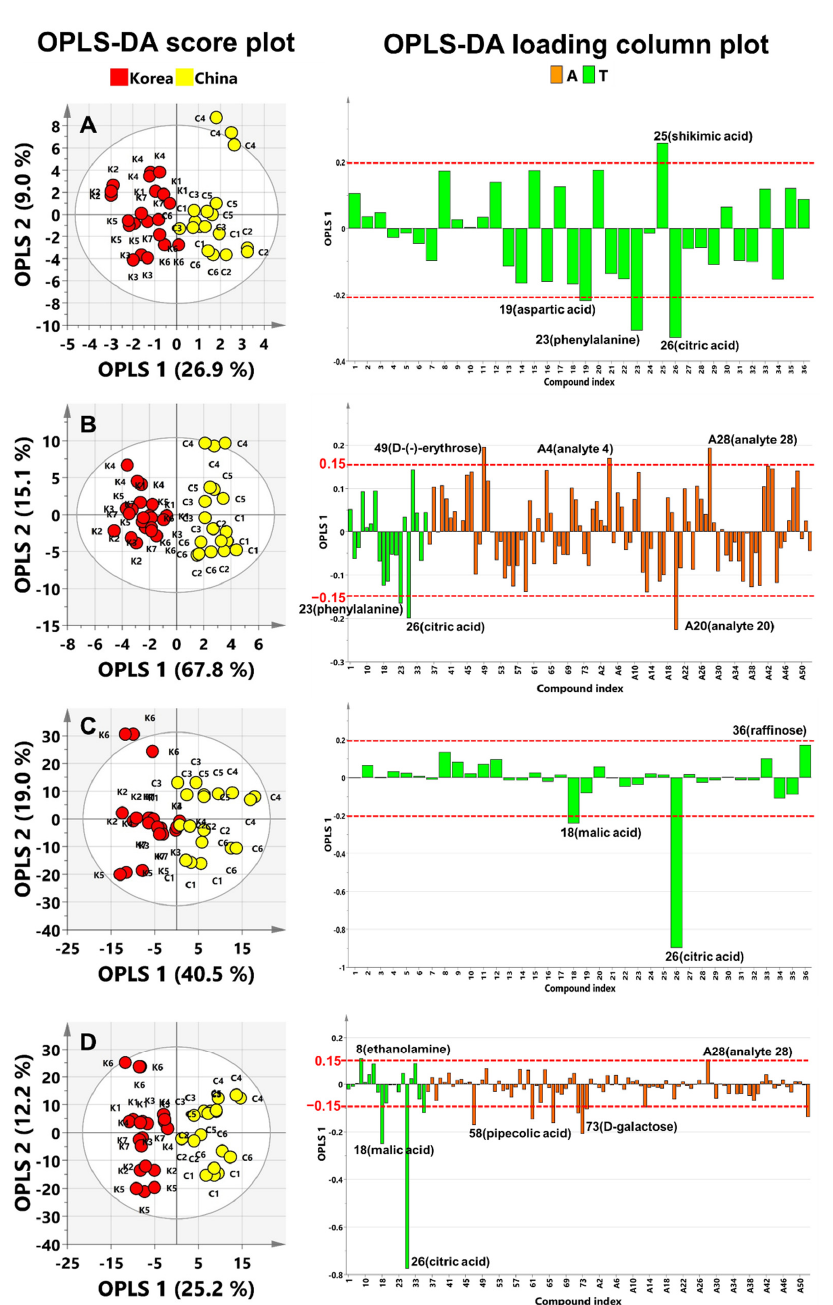
Figure 3. OPLS–DA score plots and loading column plots of targeted and non-targeted metabolite profiling platforms with UV-scaling and pareto-scaling normalisation. Score plots: ( A ), targeted, UV-scaling; ( B ), non-targeted, UV-scaling; ( C ), targeted, pareto-scaling; ( D ), non-targeted, pareto-scaling. Loading column plots: ( A ), automatically identified compounds by non-targeted metabolite profiling; T, identified compounds by targeted metabolite profiling.